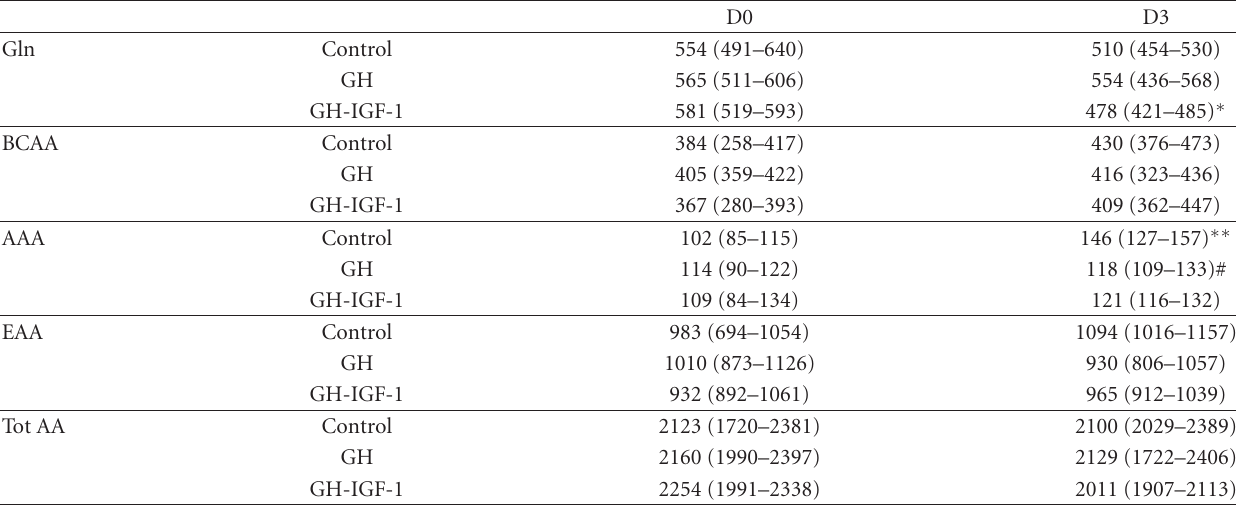
Table 6: Plasma amino acids ( μ mol/L). Glutamine (Gln), branched chain amino acids (BCAAs), aromatic amino acids (AAAs), essential amino acids (EAAs), total sum of amio acids (Tot